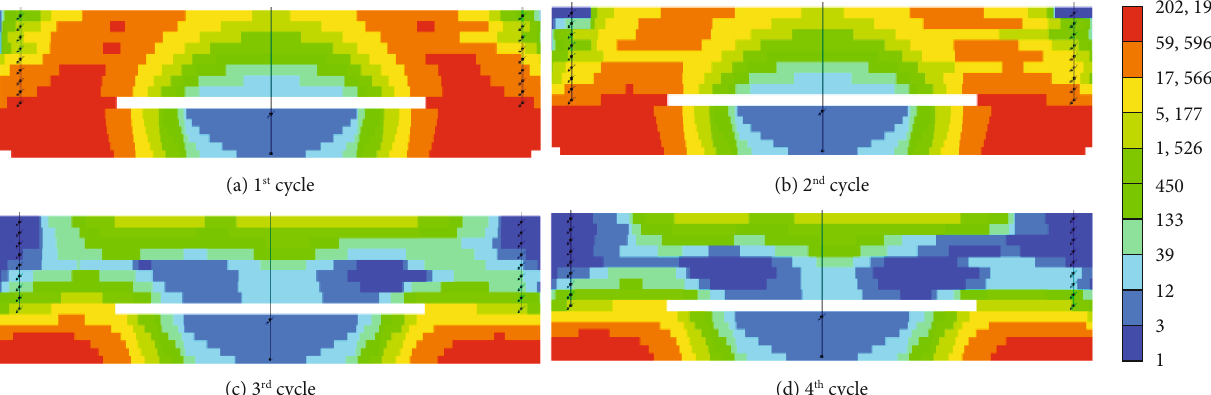
Figure 16: Oil viscosity at the end of injection of di ff erent cycles.